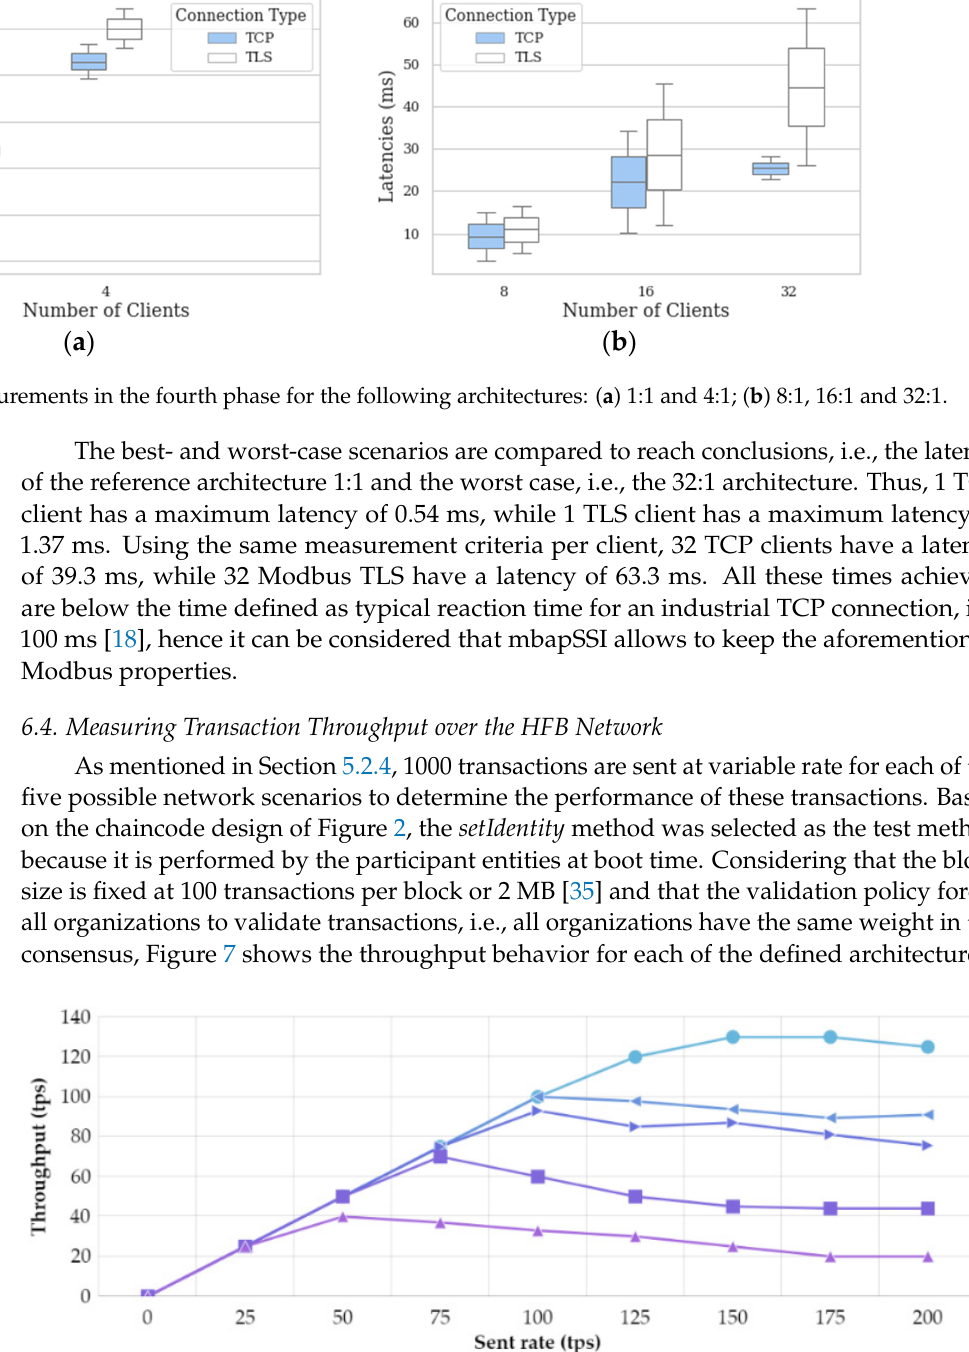
Table 6. Determination of the boot-time overhead of mbapSSI over HFB. Architecture